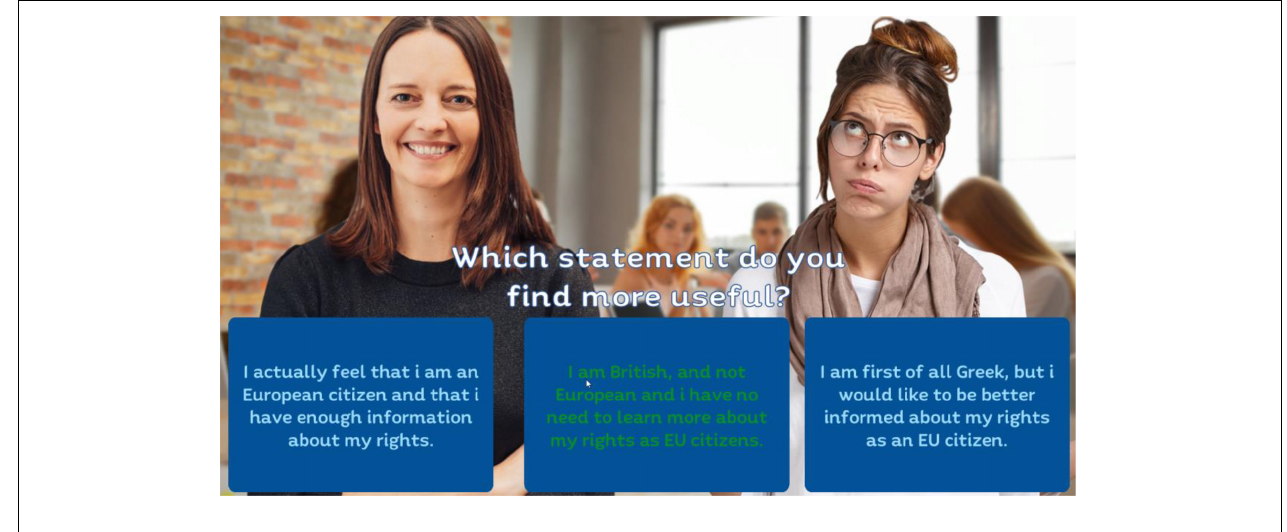
FIGURE 1 | An example of statements within the “RUEU?” game.